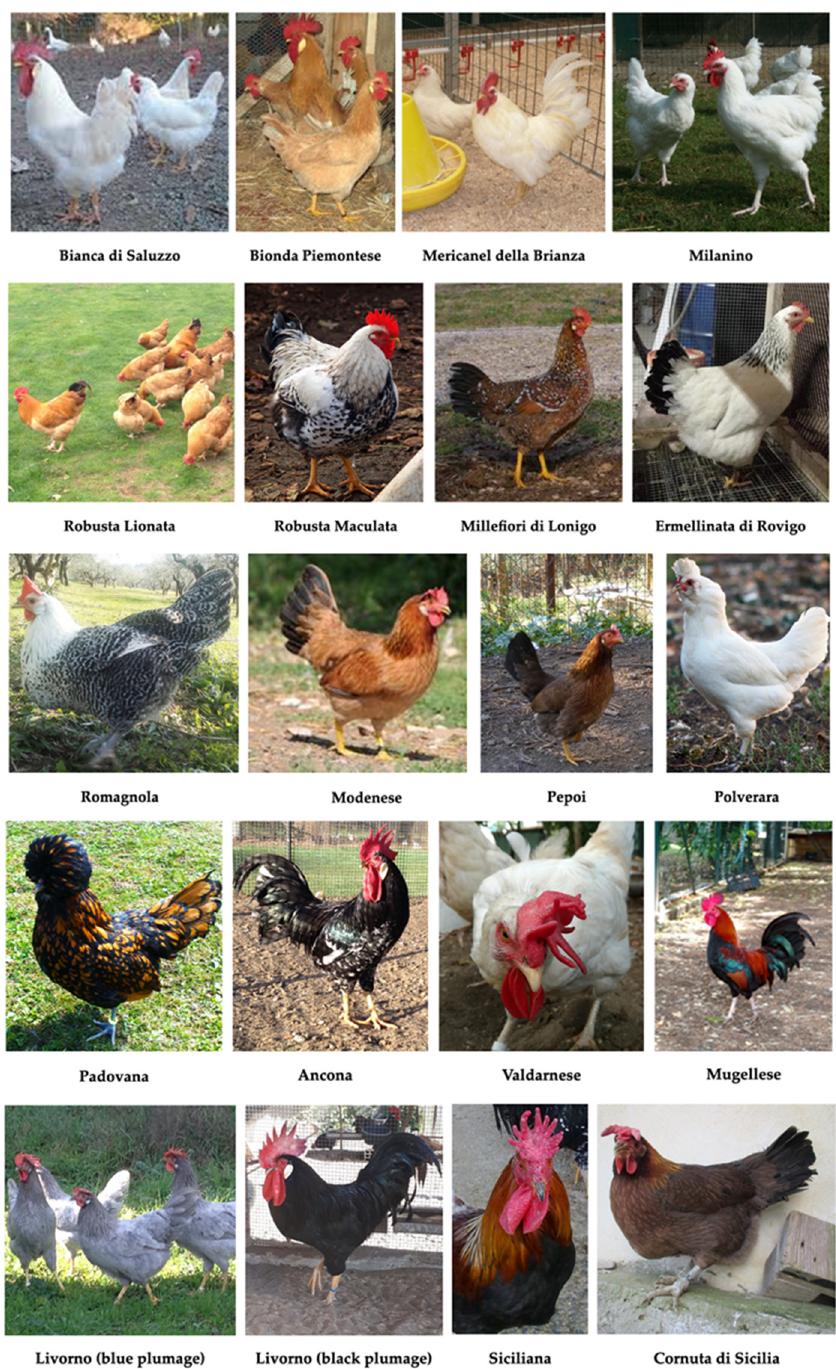
Figure 2. Main native Italian chicken breeds. Reproduced with permission from prof. Silvia Cerolini, TuBAvI Project-coordinator; published at www.pollitaliani.it/en/ (accessed on 6 February 2021) [66]. Seven native Italian turkey breeds were identified as being reared by the breeders of this study, with a total of 1010 individuals (Table 4). The Bronzato Comune (44%, n = 445) and Ermellinato di Rovigo (42%, n = 425) breeds showed the highest population sizes ( p < 0.01). These two breeds were only kept by F, who showed an evident preference for them over other breeds (Bronzato Comune 49%, Ermellinato di Rovigo 46%; Figure 3). The Parma e Piacenza (0.89%, n = 9) and Brianzolo (1.5%, n = 15; Figure 3) breeds